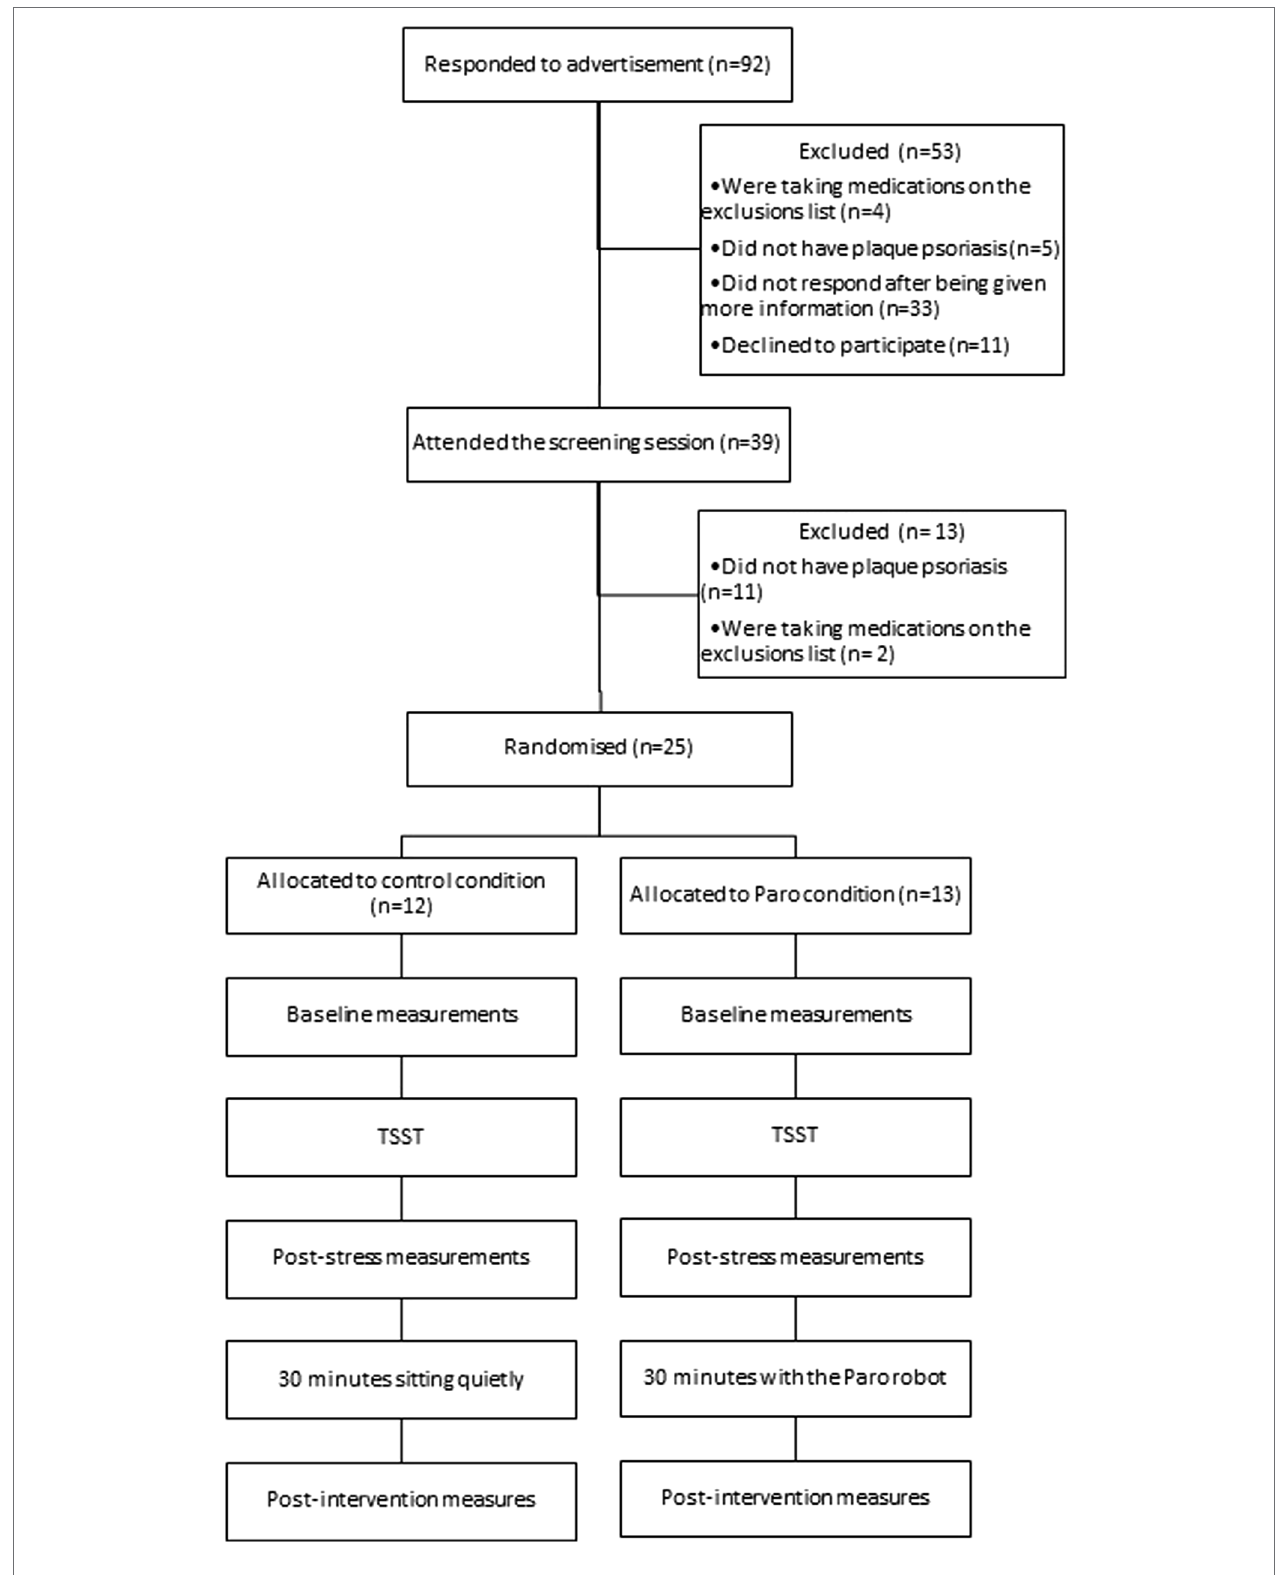
FIGURE 1 | Overview of the study